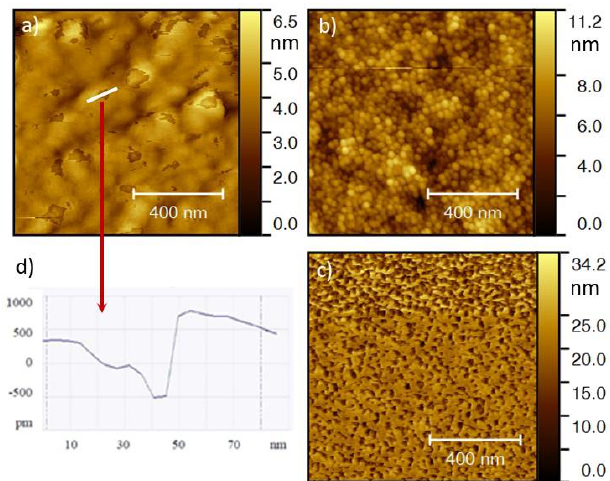
Figure 2. Atomic force microscopy (AFM) surface topographic images of ( a ) C15, ( b ) C60 and ( c ) C100 thin films deposited onto Cu coating. ( d ) 2D profile of the line highlighted in image ( a ).